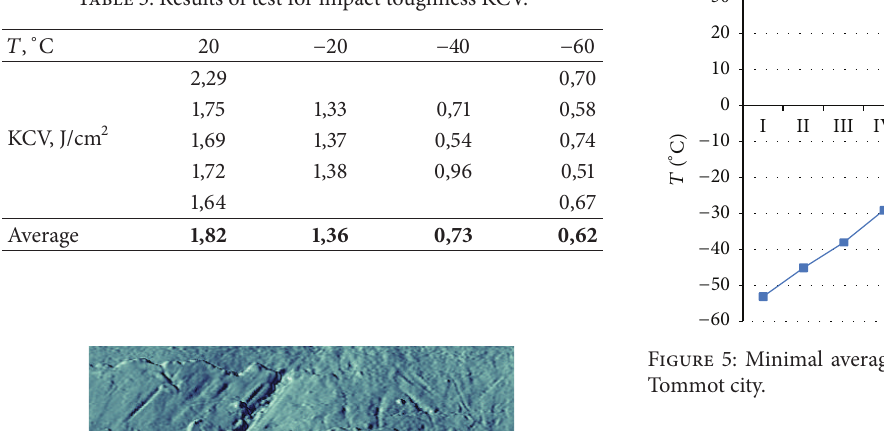
Table 3: Results of test for impact toughness KCV.